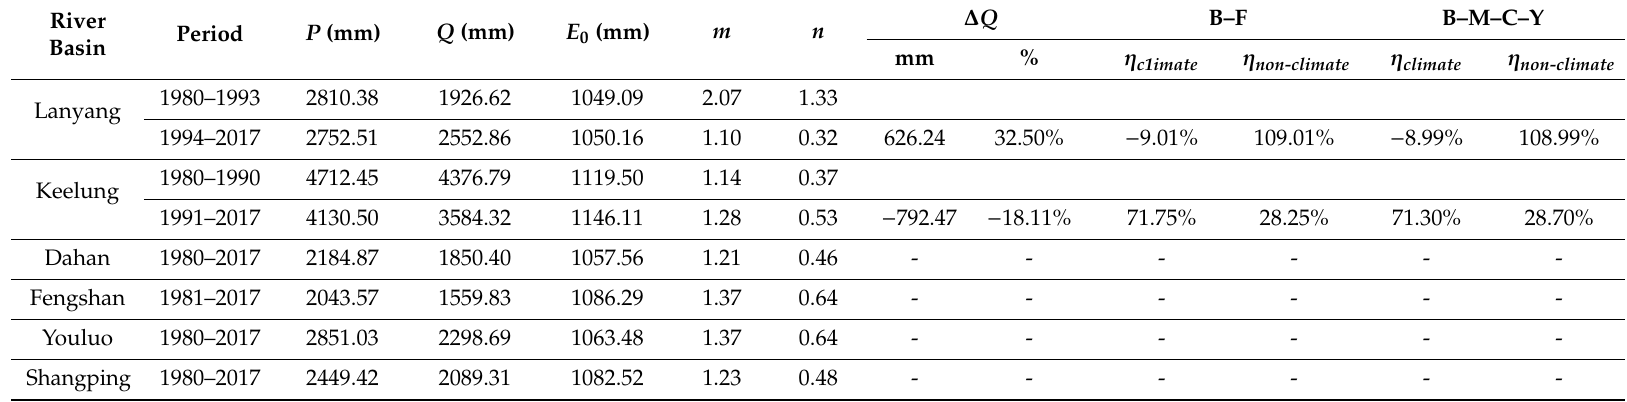
Table 4. Calculation of the streamflow variation under impacts of climate change and non-climate factors. B–F: Budyko–Fu, B–M–C–Y: Budyko–Mezentsev–Choudhury–Yang. River